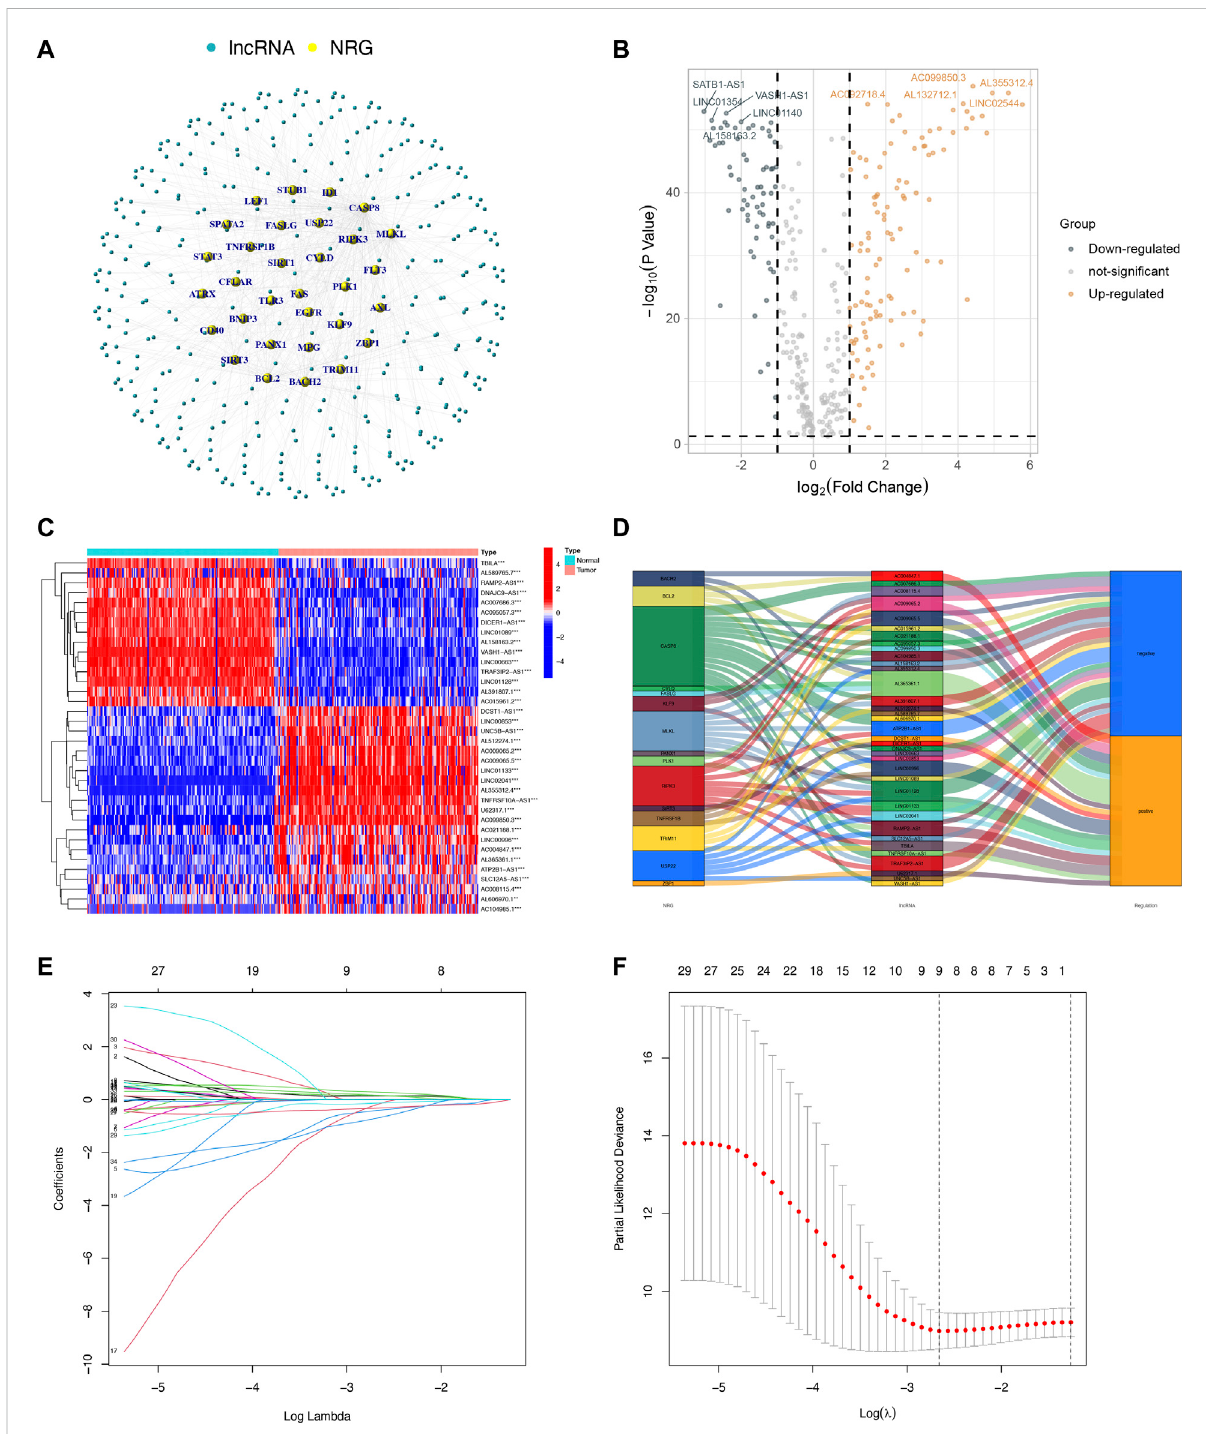
FIGURE 1 Identi fi cation and selection of NRL prognostic signatures in PAAD. (A) Coexpression network between NRGs and NRLs (|Pearson correlation coef fi cients| > 0.7,and p < 0.001). (B) Volcanoplotof172DENRLs. (C) Theexpressionpro fi lesof36prognostic-relatedNRLs. (D) TheSankeydiagram of prognostic NRLs, NRGs, and risk type. (E) The LASSO coef fi cient pro fi le of necroptosis-related lncRNAs. (F) The 10-fold cross-validation for variable selection in the LASSO